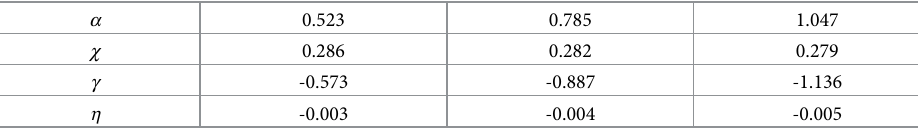
Table 3. The fitted values of coefficients, χ , γ and η